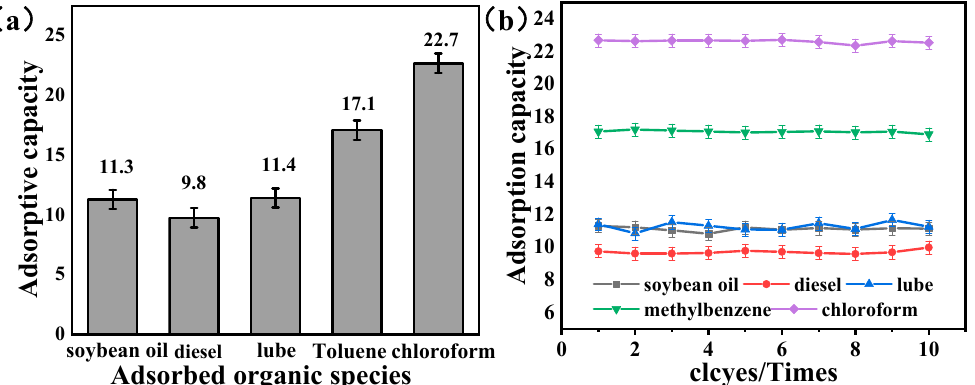
Figure 9. The nano-HAp/PU sponge maximum absorption for variety of organics ( a ) initially; ( b ) in absorption cycle effect.